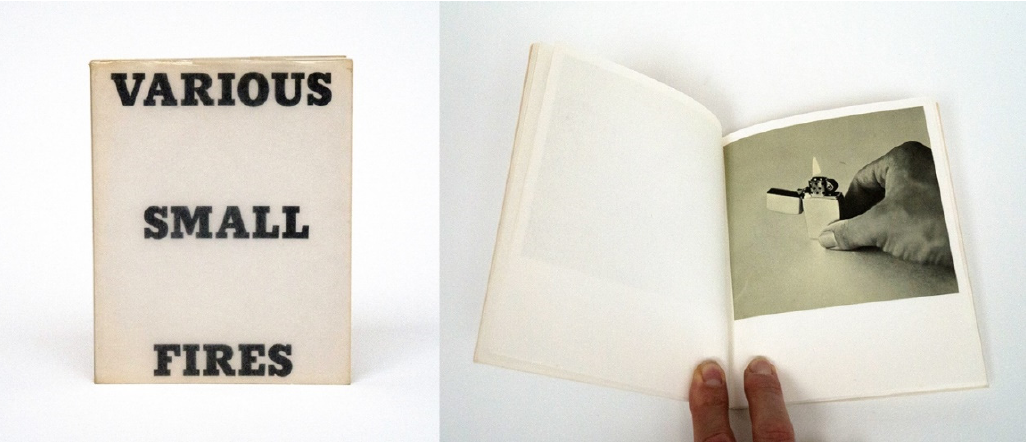
Figure 2. Edward Ruscha, Various Small Fires and Milk , 1964.